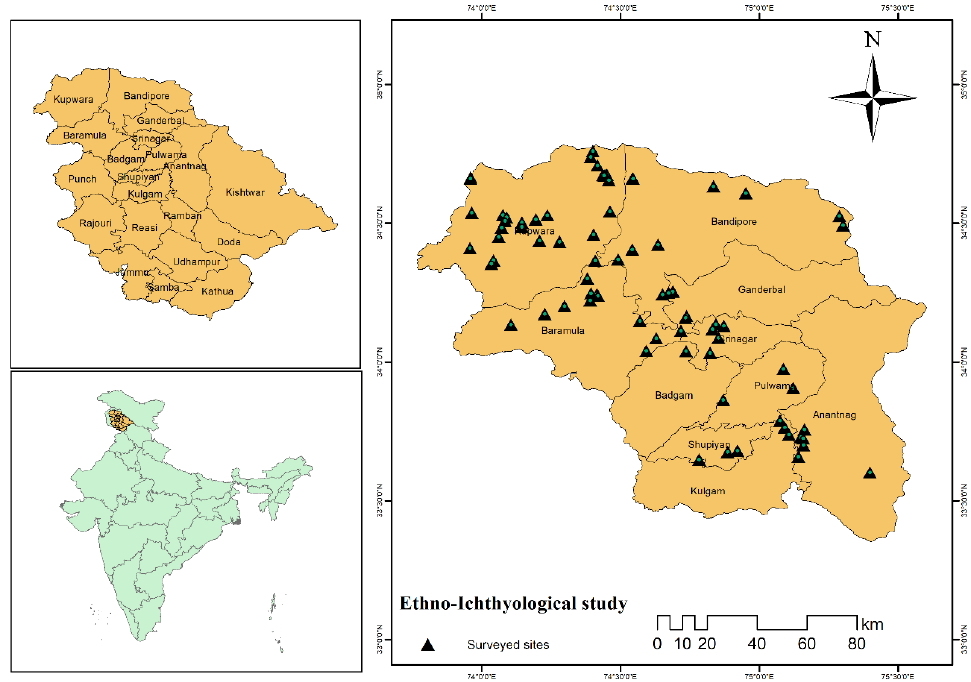
Figure 1. Map of the Kashmir valley, India, and points showing the survey